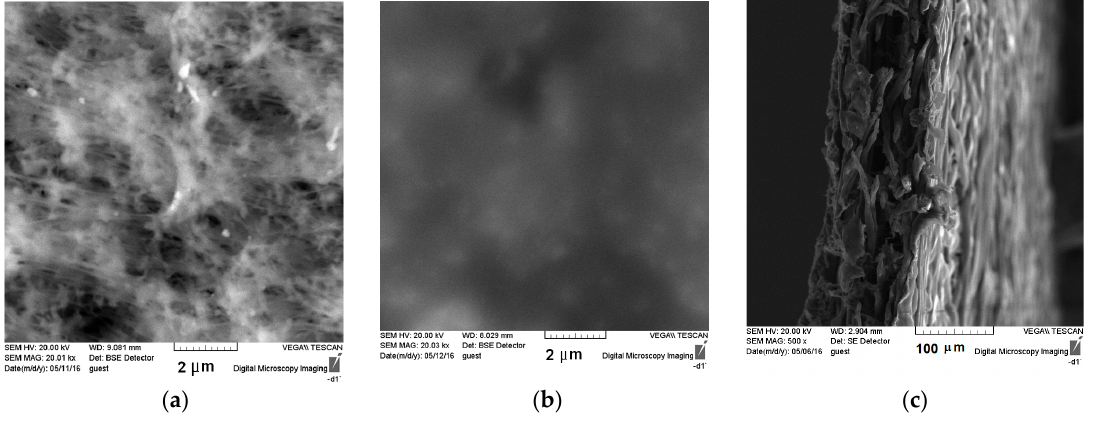
Figure 3. Scanning electron micrographs of the polymeric membrane surface of MFFK-1 before ( a ) and after ( b ) immobilization of bmim[OAc]; ( c ) the cross-section of the membrane. Table 2. Contact angle of ionic liquids on MFFK-1 and calculated capillary pressure.